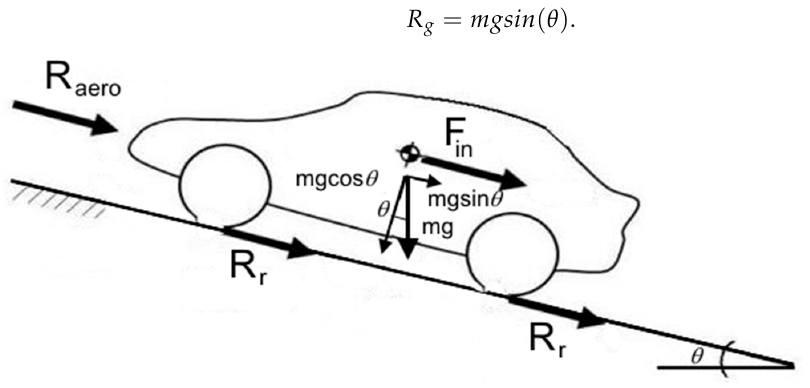
Figure 3. Vehicle model and diagram of motion resistances.